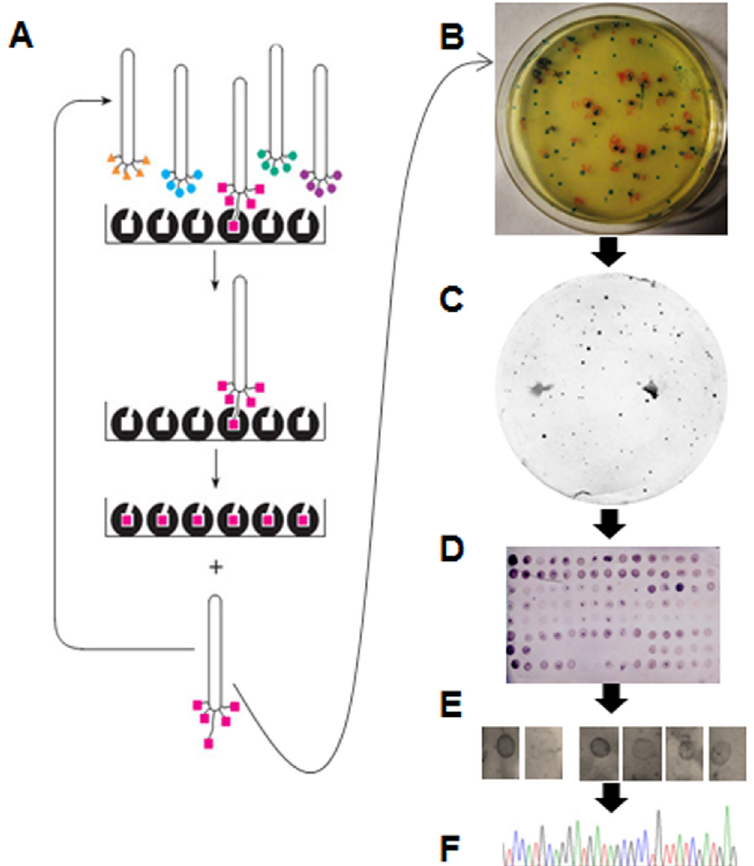
Fig 1. Diagrammatic representation of the workflow applied in affinity purification of M13 phage clones that displayed FvTox1-interacting synthetic peptides. (A), Bio-panning of the phage display libraries on plastic surface of a microtiter plates coated with 1.5 ml FvTox1 (30 ng/ μ l). Unbound phage particles were washed off; and M13 phage particles bound to FvTox1 were used to infect E . coli for starting a second round of panning. The process was repeated once more. (B), Plating of candidate M13 phage clones displaying FvTox1-interacting peptides. An eluate from the last panning in A was plated on X-gal/IPTG agar plates. (C), Identification of candidate M13 phage clones displaying FvTox1-interacting peptides. Phage clones were adsorbed onto nitrocellulose paper and hybridized to the His-tagged purified FvTox1 proteins. FvTox1-interacting clones were identified by detecting FvTox1 with the anti-His antibody. (D), Western blot analysis of the selected phage clones for interaction with FvTox1. Selected M13 phage particles from plates in C were transferred to nitrocellulose filters and hybridized to FvTox1, which was detected with an anti-His antibody. (E), Western blot analysis of the selected clones for interaction with FvTox1. Selected clones in D were reinvestigated for interaction with FvTox1, adsorbed onto a nitrocellulose membranes and detecting the interaction of individual clones to FvTox1 with an anti-M13 antibody (Details are presented in S2 Fig). (F), Electropherogram of a nucleotide molecule encoding an FvTox1-intearcting peptide is presented.